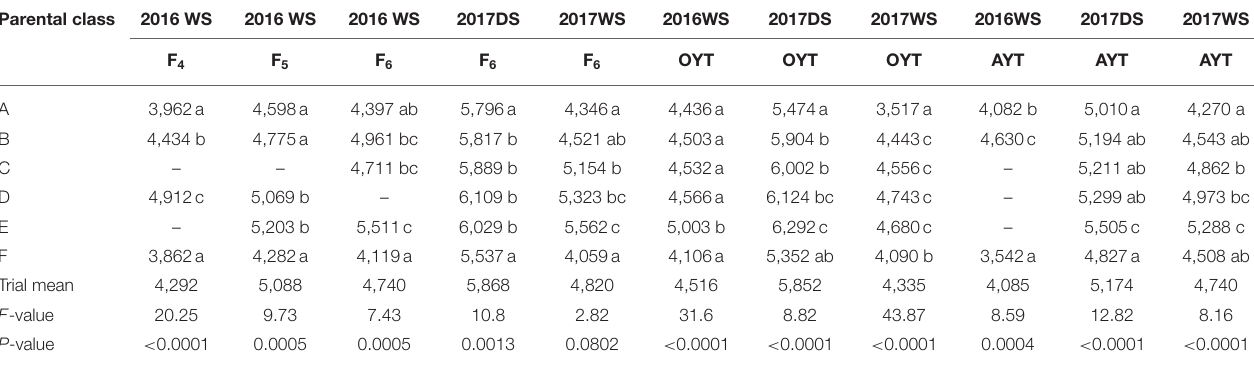
TABLE 4 | Mean comparison of QTL classes for grain yield (kg ha − 1 ) from the F 4 to F 6 generations in observational and advanced yield trials under direct-seeded cultivation